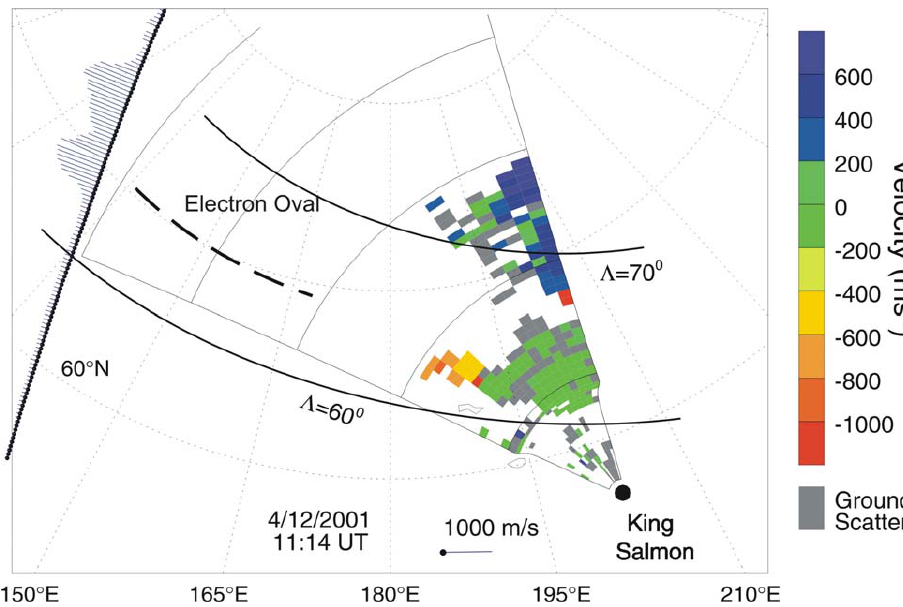
Fig. 13. (a) King Salmon velocity map for 4 December 2001, 11:14 UT with overlaid DMSP cross-track ion drifts for a DMSP F 15 pass near the time of radar measurements. A blob of high velocity KS echoes is clearly identifiable as a red spot. The ion velocity shows two peaks, with one being well outside the auroral oval. The KS high-velocity blob is located at similar latitudes as the equatorward peak seen by DMSP.